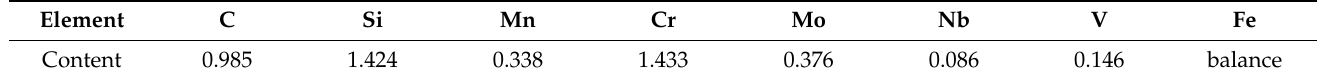
Table 1. Element content of the designed steel